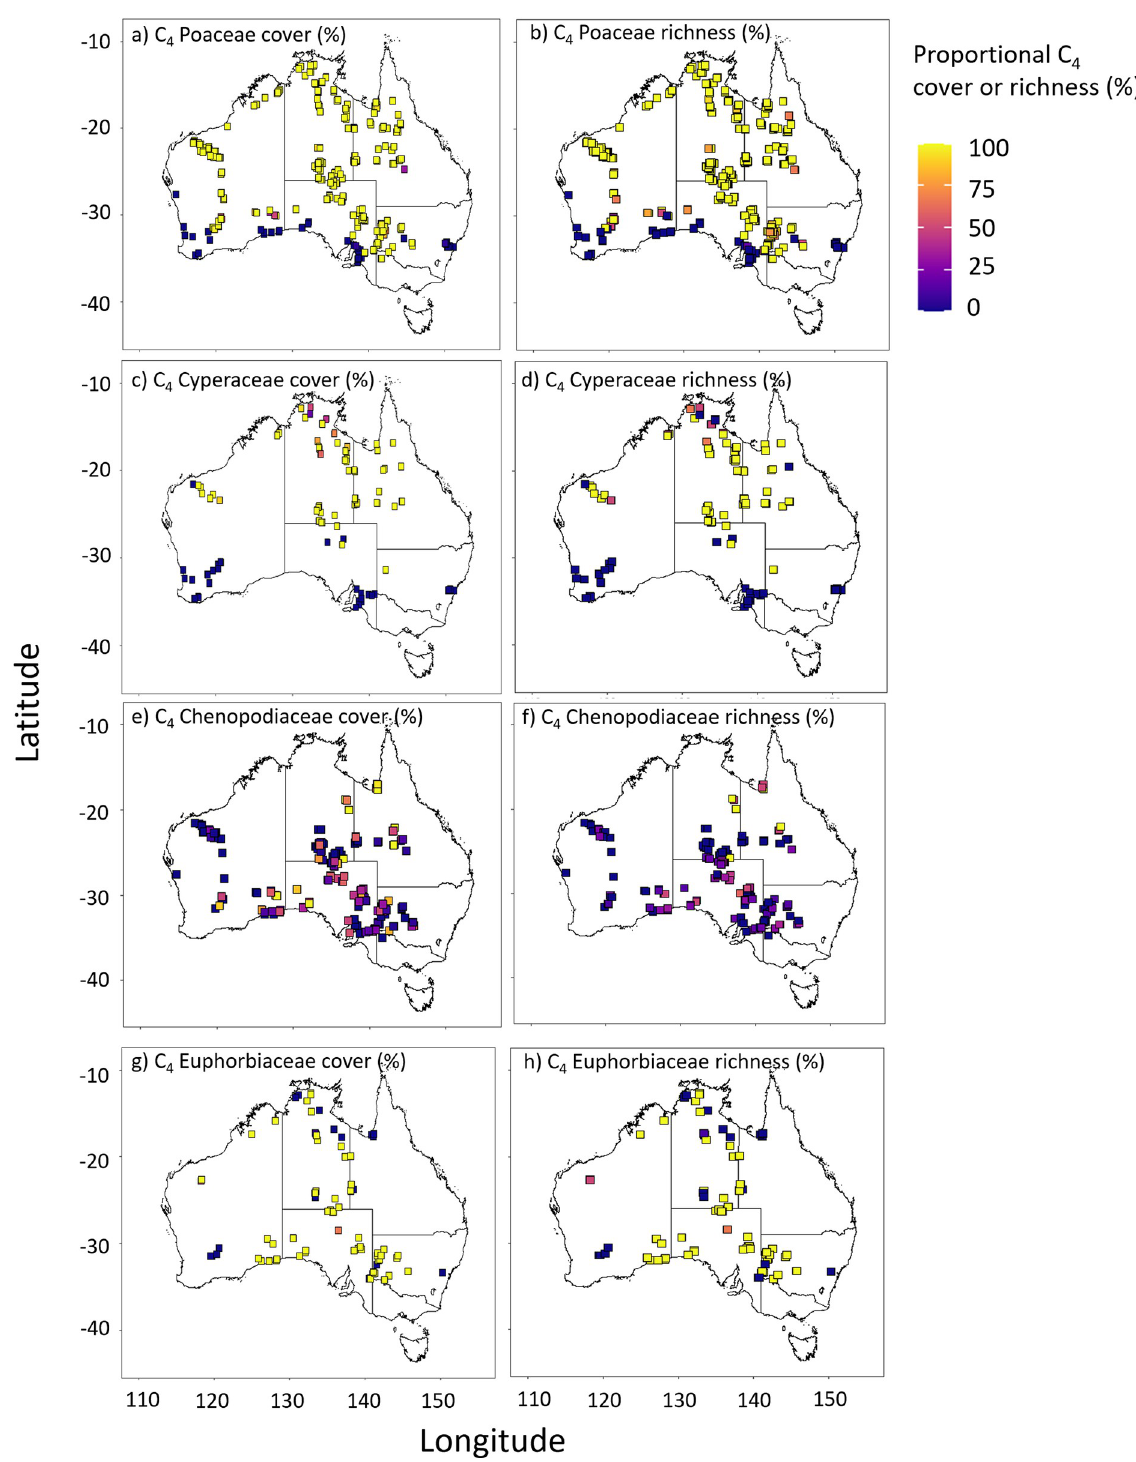
Fig 1. Proportional C 4 cover and richness at TERN monitoring plots. (a, b) Poaceae, (c, d) Cyperaceae, (e, f) Chenopodiaceae, and (g, h) Euphorbiaceae.